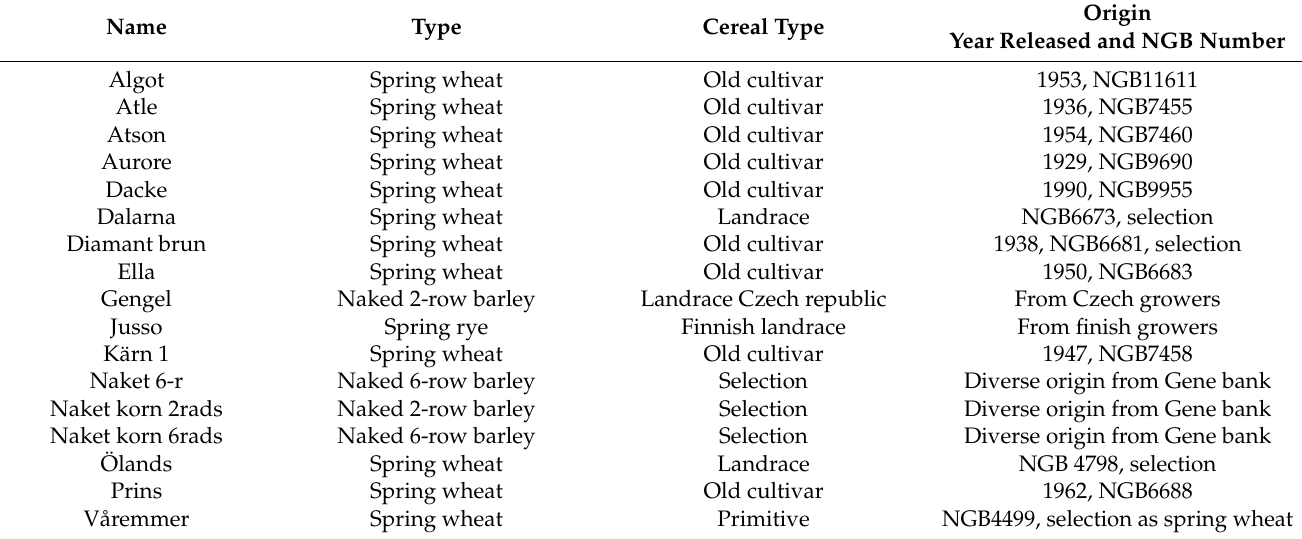
Table 1. Name, type of cereal, and origin (year released, NGB number at Nordgen and if selections have been made on the material) of cereals used in the present